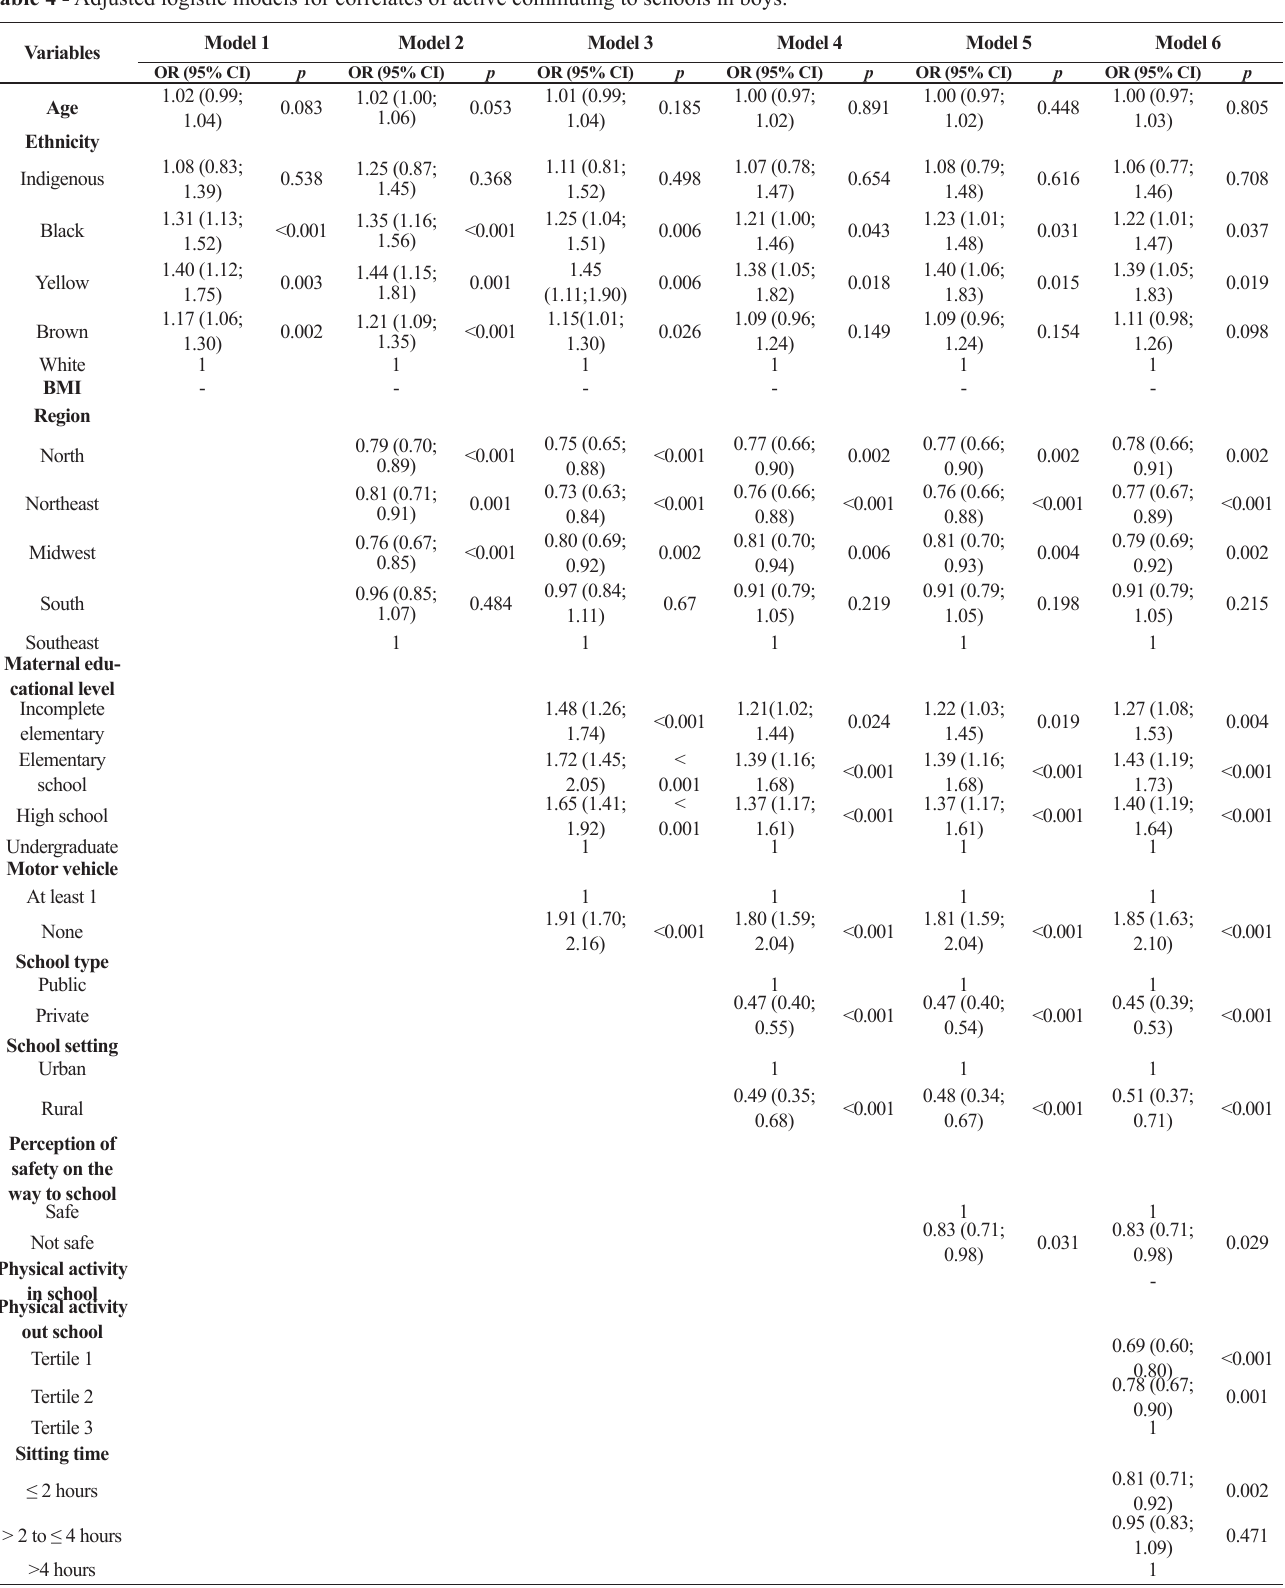
Table 4 - Adjusted logistic models for correlates of active commuting to schools in